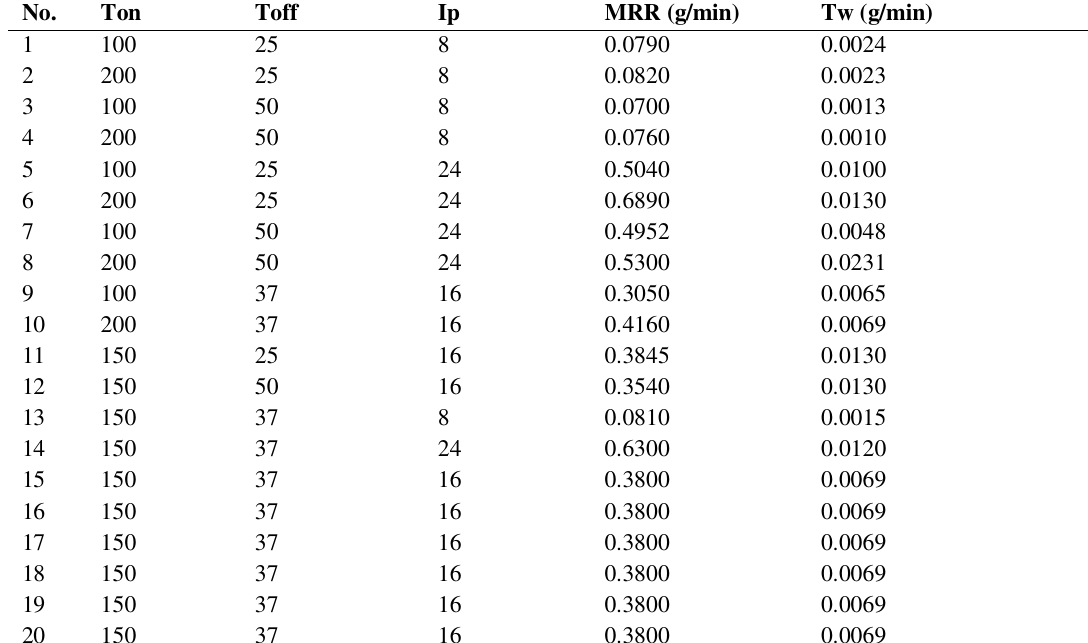
investigated using MINITAB 17 software